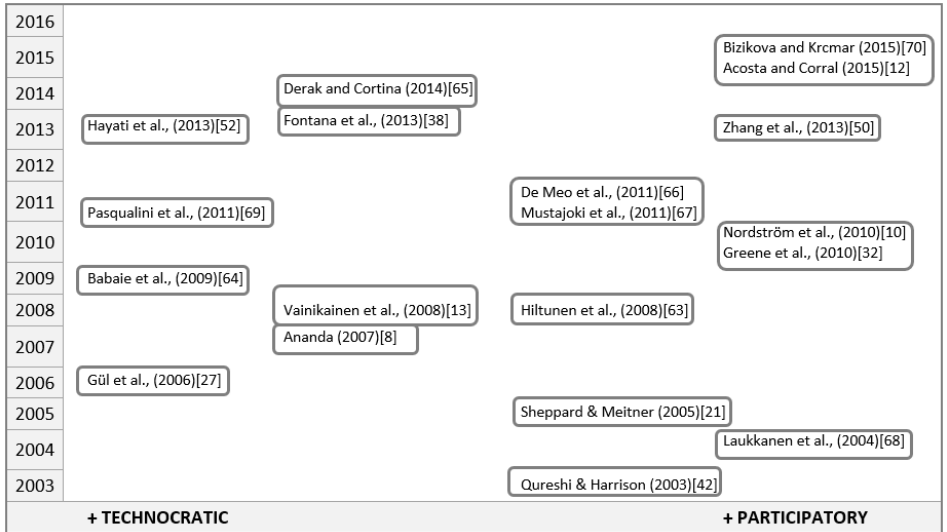
Figure 3. Classification of research according to degree of participation. Based on [8,10,12,13,21,27,32,38,42,50,52,63–70].